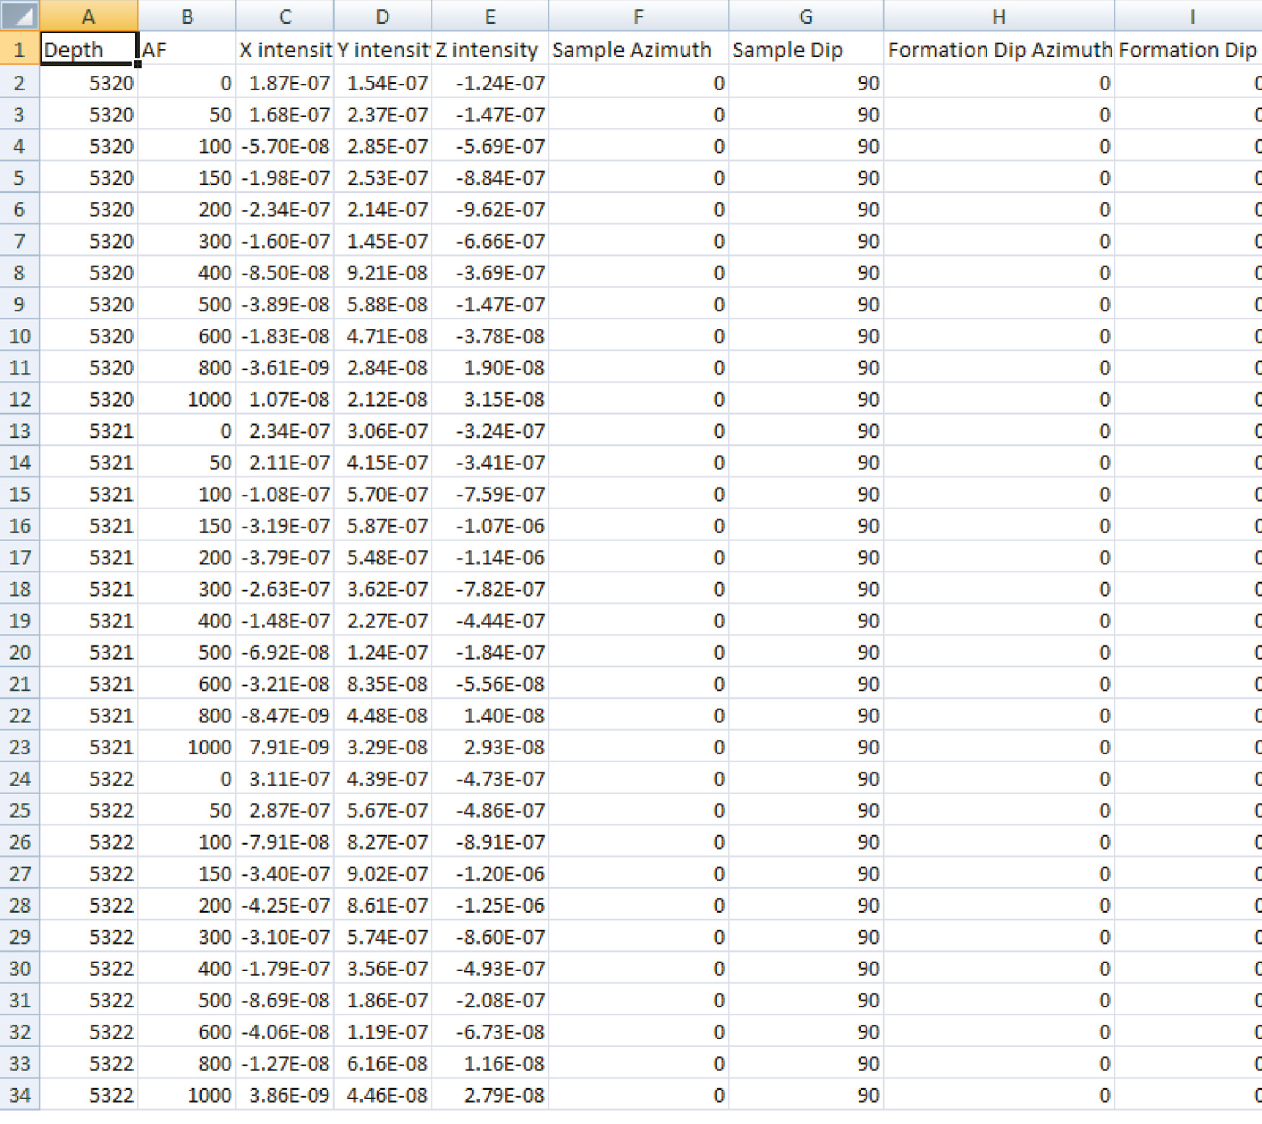
Figure 2. The structure of input data. Only 9 parameters are required in input, listed in columns A to I of the OriginalData worksheet. Input data should be ordered according to column